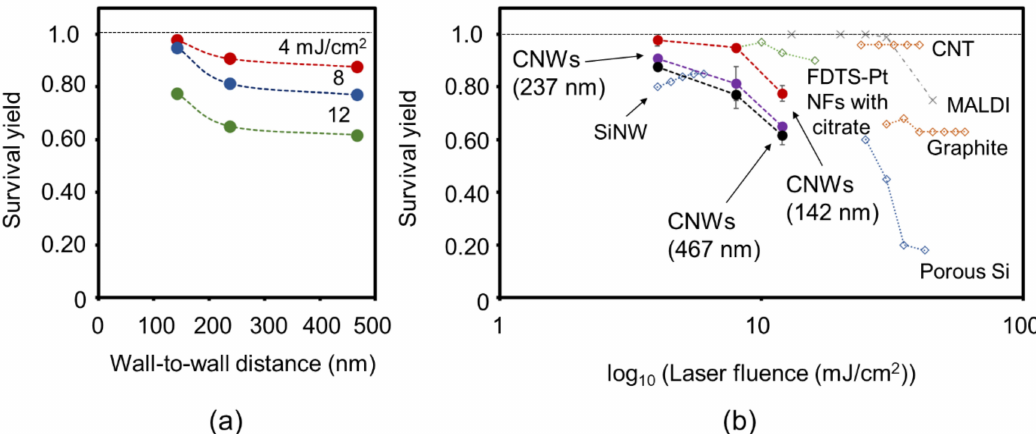
Figure 6. Survival yield (SY) of N-BP-Cl desorbed from substrates with different wall-to-wall distances CNWs as a function of ( a ) wall-to-wall distance and ( b ) laser fluence. (SYs for other nanomaterials were taken from the literature (Si nanowires (SiNWs) and porous Si [20]; perfluorodecyltrichlorosilane-modified platinum nanoflowers (FDTS-PtNFs) with citrate and MALDI (a-cyano-4-hydroxycinnamic acid (CHCA)) [22]; carbon nanotubes (CNTs), graphite